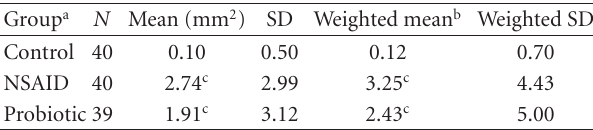
Table 1: Total damaged area of the rat stomach mucosa.